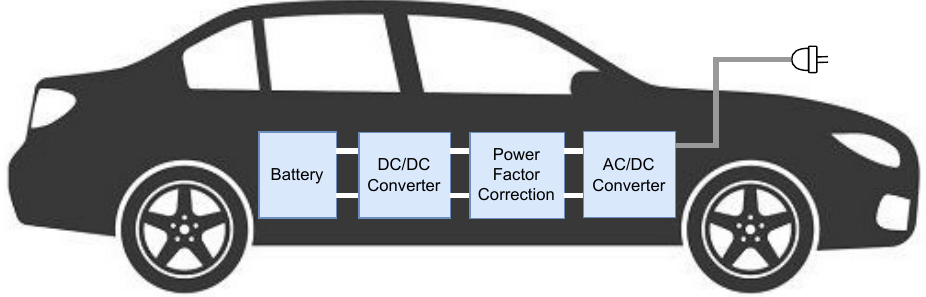
Figure 2. Structure of a slow charger